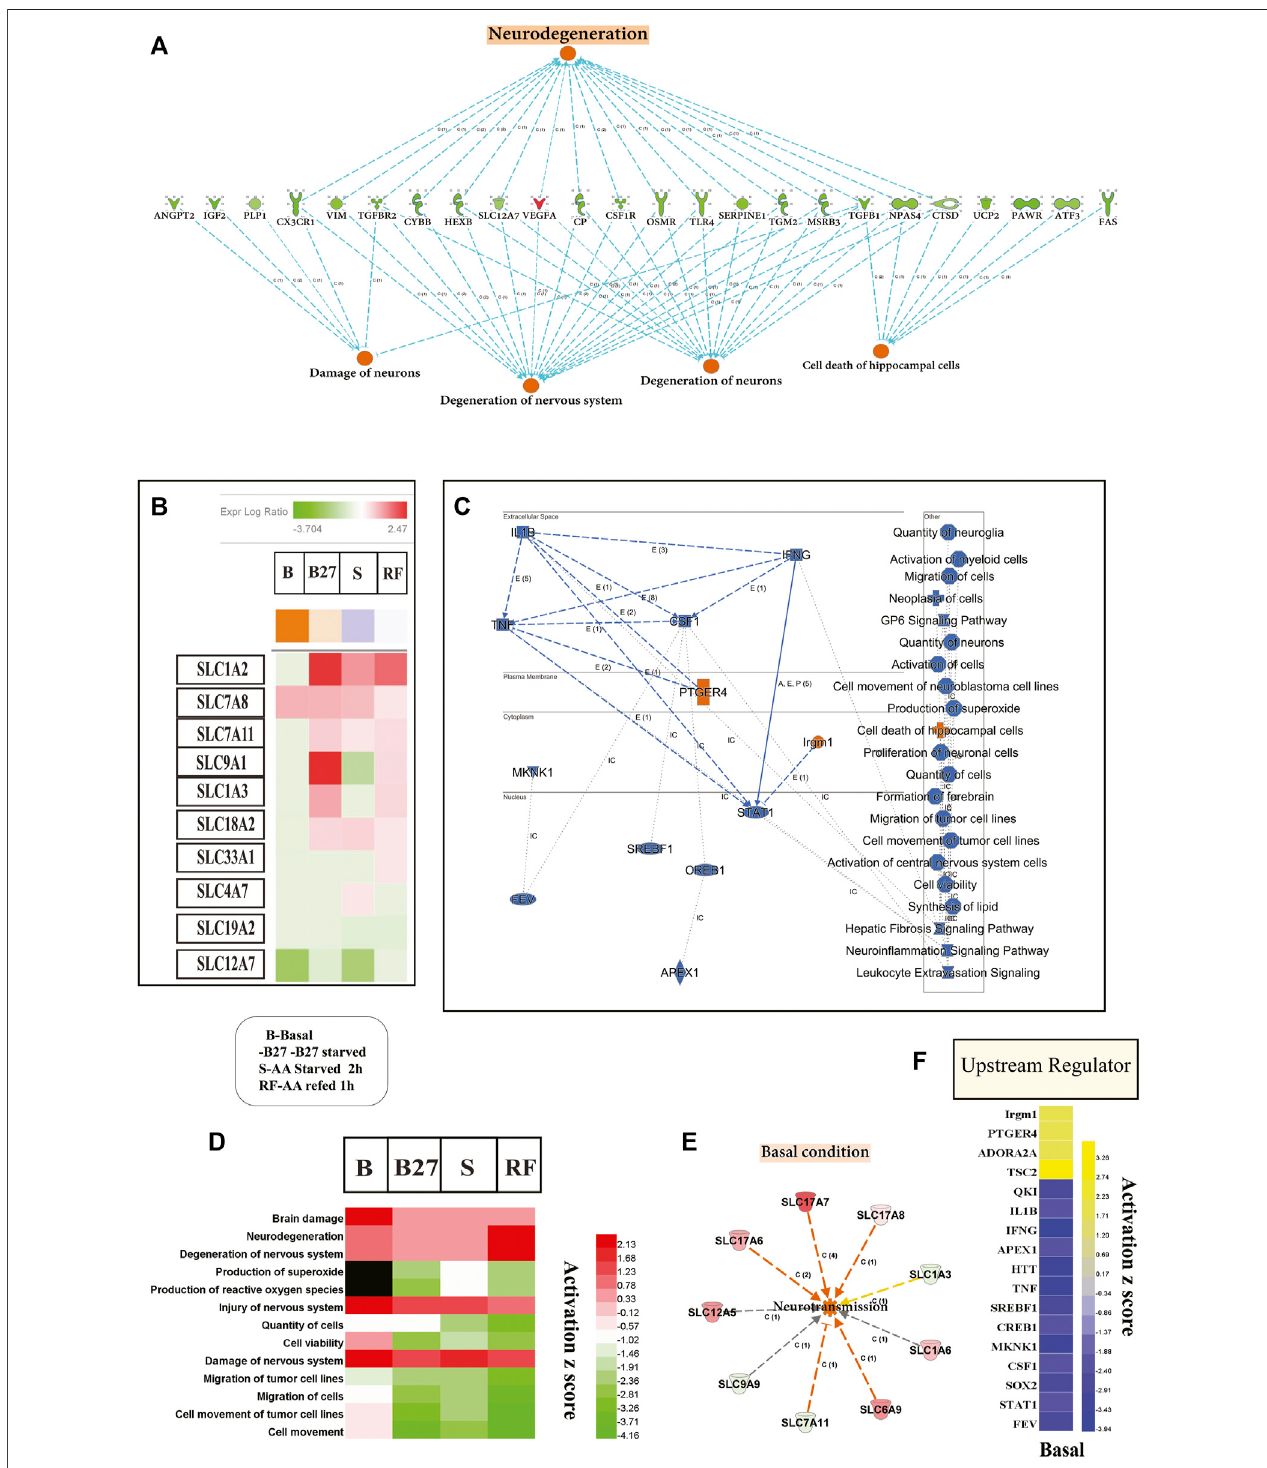
FIGURE 5 | The absence of SLC3A10 leads to transcriptome changes of genes in KO PCCs involved in modifying cellular, molecular functions and indicating neurological disease. Complete transcriptomic data and changed gene list subjected to IPA software and focused analysis performed on neurological function and disease. (A) Representation of genes from a basal level of transcriptomic data indicated a rise in neurodegeneration of KO PCCs (B) . Heat-map representation of solute carrier transporter involved in neurodegeneration and affected expression under B, B27, S, and RF levels. (C) Repre-sentation of overall summary changes of molecules of Transcription regulator (TR), cytokine-Kinase-K- Enzyme- E, G-protein coupled receptor-GPCR, at a subcellular level, cellular, molecular functions, and